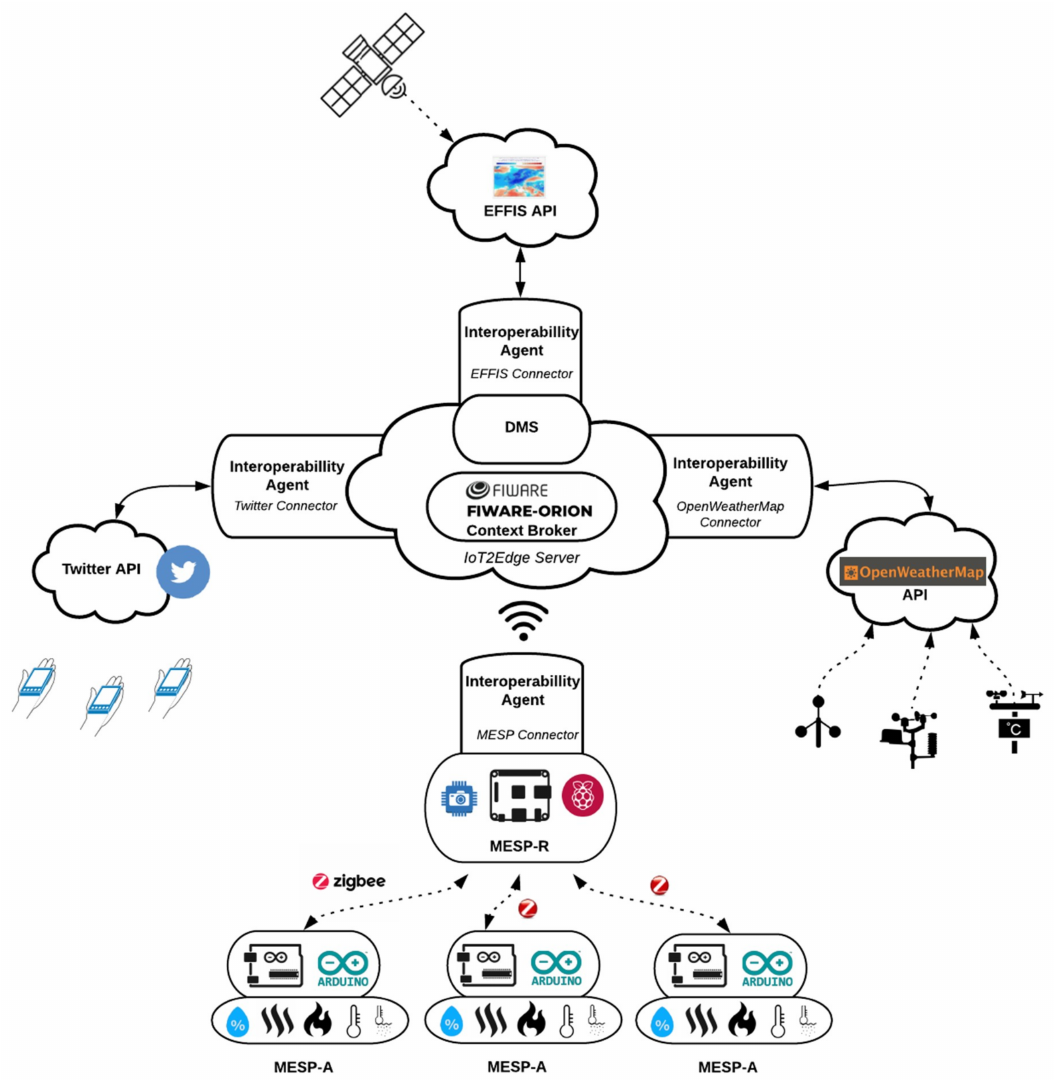
Figure 10. Deployment of IoT2Edge data interoperability modules for retrieving data from information platforms participating to the